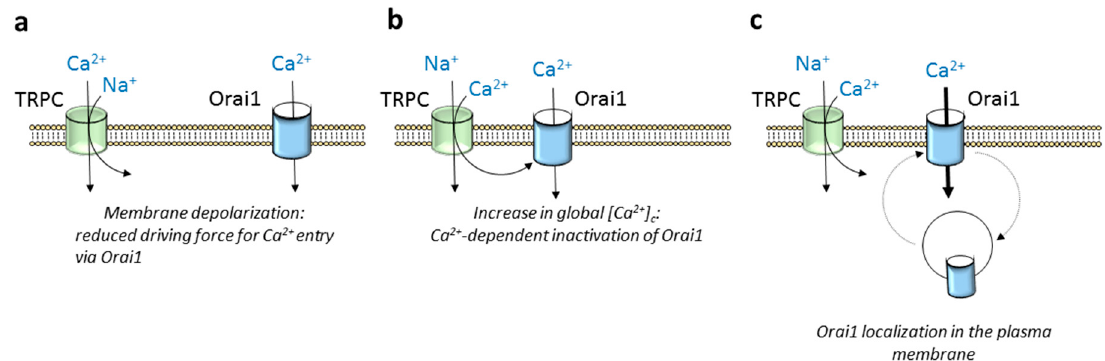
Figure 3. Overview of the modulation of Orai1 by TRPC channels. Orai1 channel function might be positively or negatively regulated by TRPC channels in the vicinity. ( a ) Ca 2 + and Na + entry through TRPC channels might lead to membrane depolarization and thus attenuation of the electrical gradient that favors Ca 2 + influx via Orai1. ( b ) Ca 2 + entry via TRPC channels participates in global rises in [Ca 2 + ] c , thus leading to Ca 2 + -dependent inactivation of Orai1 channels. ( c ) Some TRPC channels are required for Orai1 recycling at the plasma membrane.